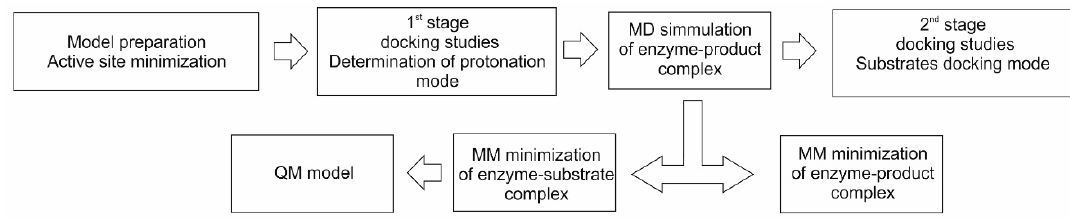
Figure 3. The modeling protocol used in the study.